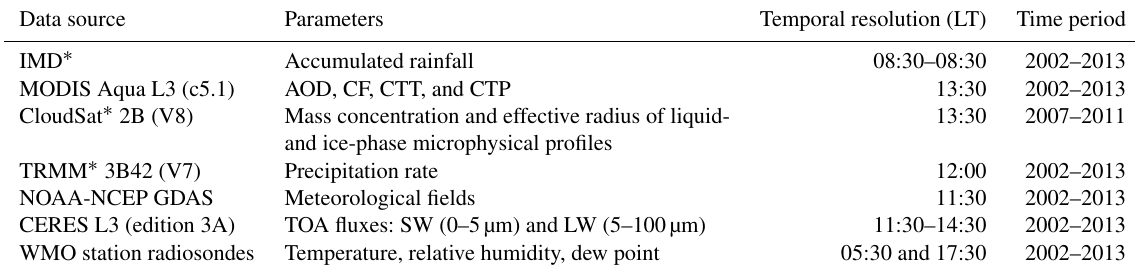
Table 1. Summary of daily dataset used in our analysis. LT refers to local time; TOA: top of the atmosphere; SW: shortwave; LW: longwave. Data